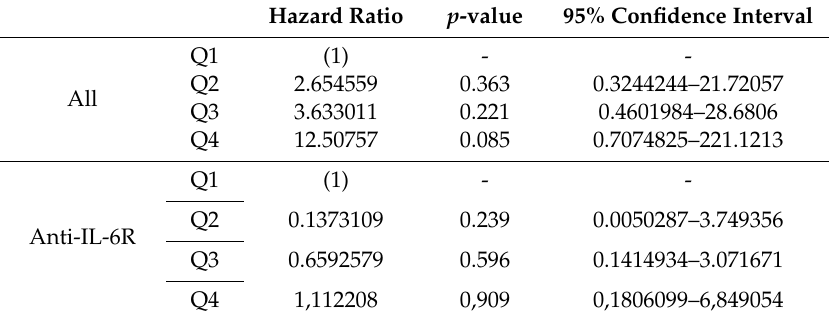
Table 6. Multivariate survival analysis for quartile distribution of serum iron.